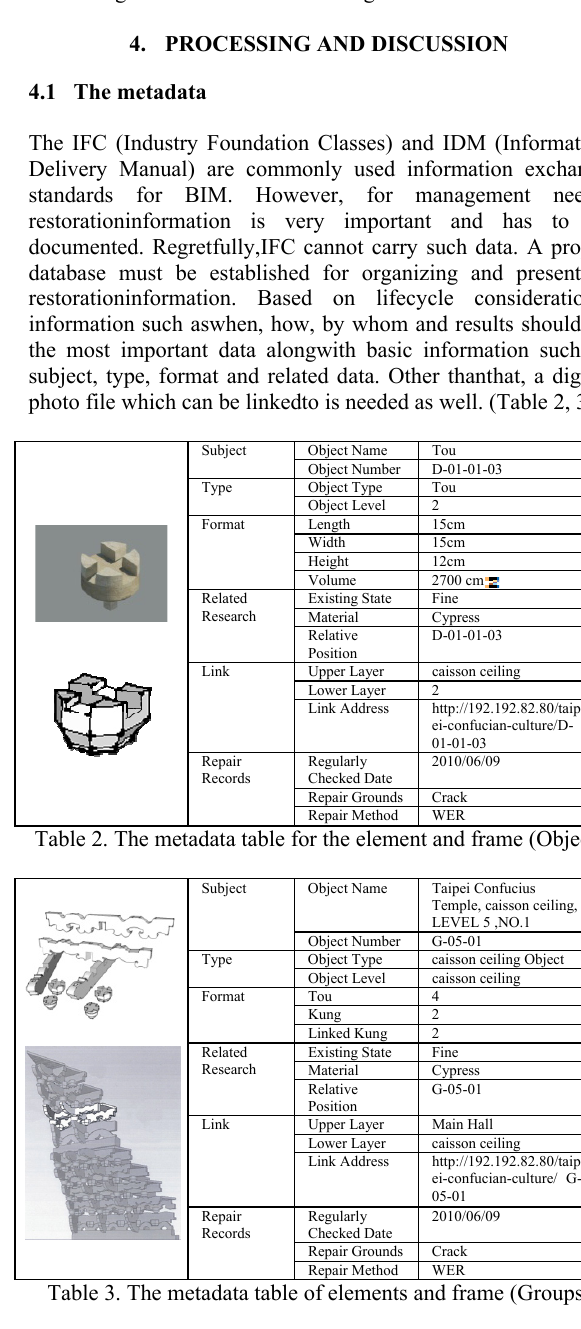
Fig 6. BIM information management architecture